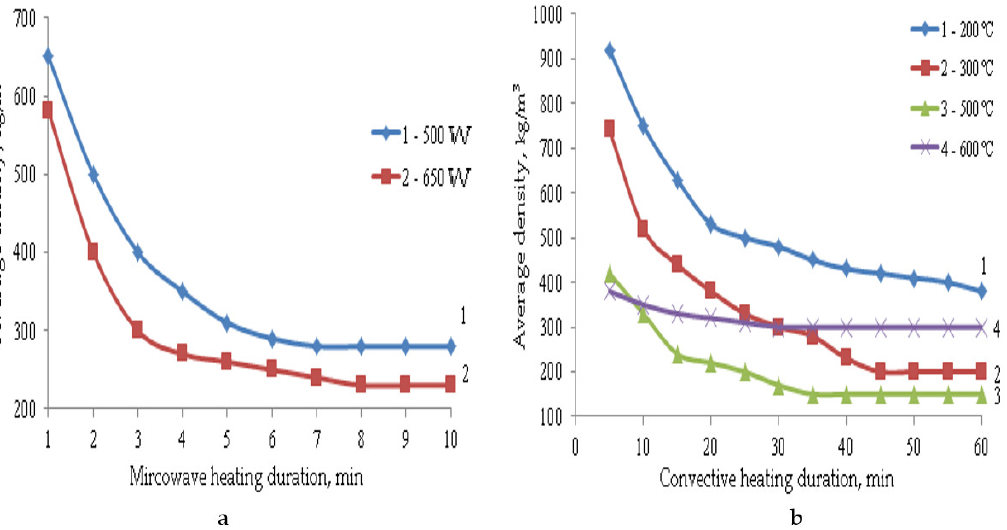
Figure 5. Dependence of the average density on the parameters of microwave ( a ) and convective ( b ) heating.